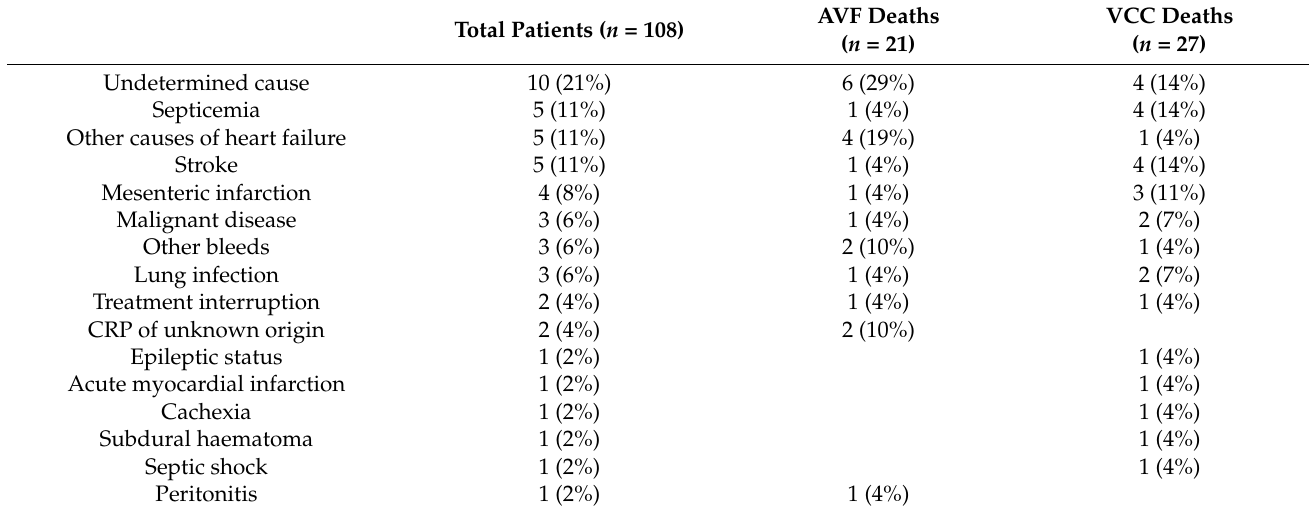
Table 4. Causes of death according to vascular